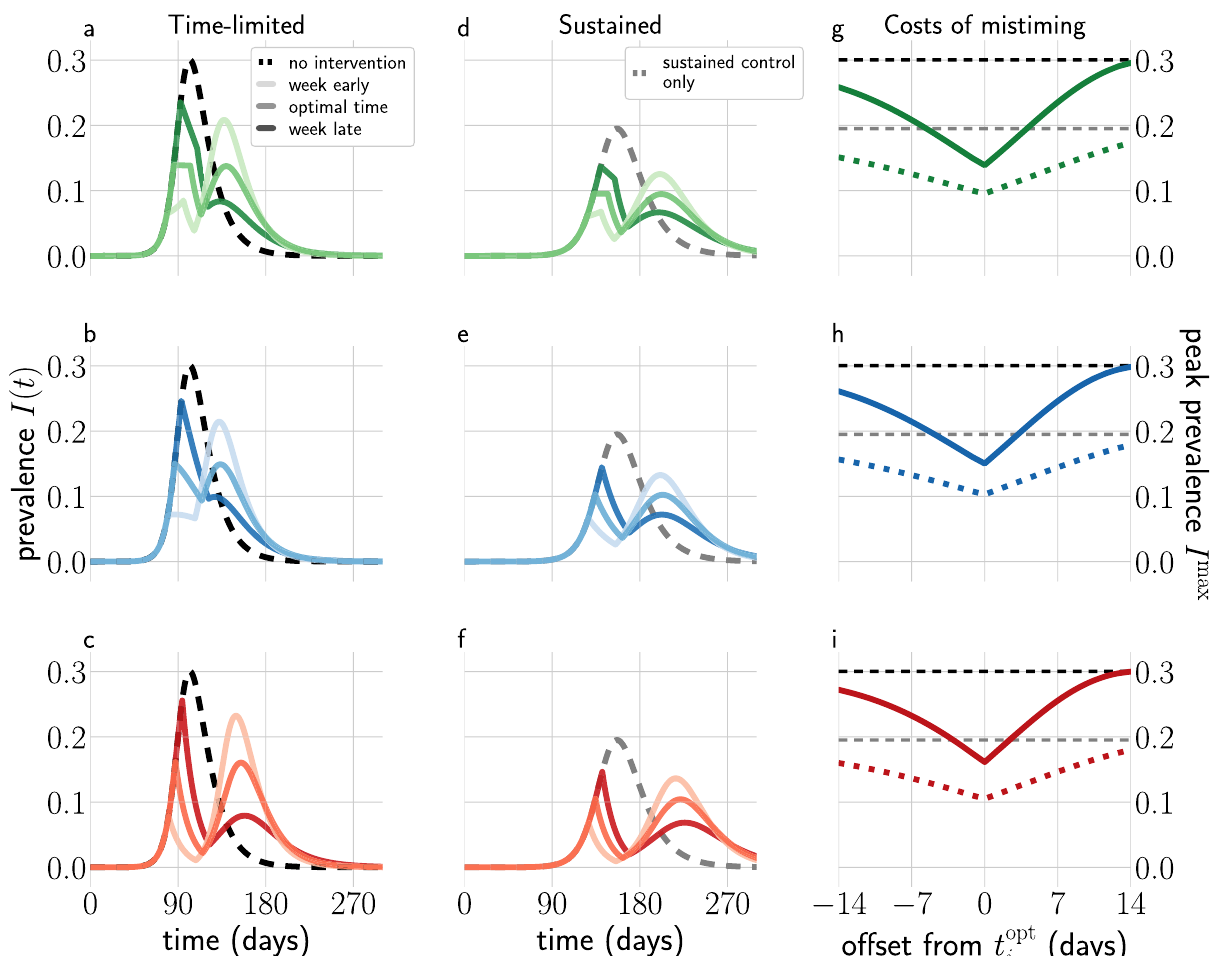
Fig. 2 Mistiming an intervention reduces its effectiveness. a – f Time courses of epidemics under optimal ( a ), fi xed control ( b ), and full suppression ( c ), interventions that are possibly mistimed: a week late (dark lines), optimally timed (intermediate lines), and a week early (light lines). Dashed black line shows time course in the absence of intervention. d – f Time courses of epidemics with a sustained control that reduces the basic reproduction number R 0 by 25%, combined with the effects of possibly mistimed optimal ( d ), fi xed control ( b ), and full suppression ( f ) interventions, with line lightness as before. Dashed gray line shows time course with only sustained control and no additional intervention. g – i Effect of offset of intervention time t i from optimal intervention time t opt i on epidemic peak prevalence I max without (solid lines) and with (dotted lines) sustained control for optimal ( g ), fi xed control ( h ), and full suppression ( i ) interventions. Dashed black and gray lines show I max in the absence of intervention, without and with sustained control, respectively. Plotted parameters: R 0 ¼ 3 and γ ¼ 1 days − 1 . See Table 1 for parameter justi fi 14